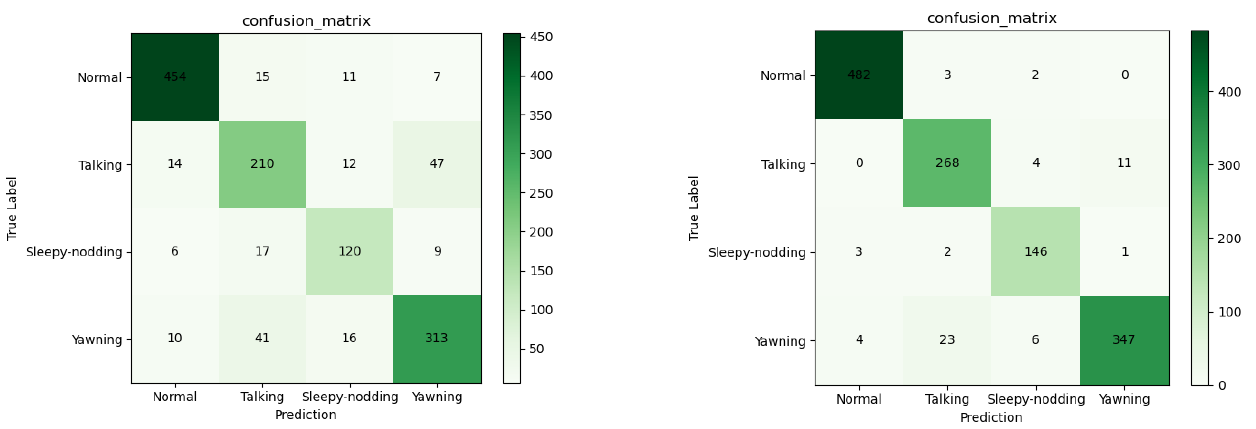
Figure 8. Confusion matrix of 3D-CNN on FDF test set ( Left ); confusion matrix of 3D-SE-Net on FDF test set ( Right ). Table 2. Performance evaluation results on the FDF test set.